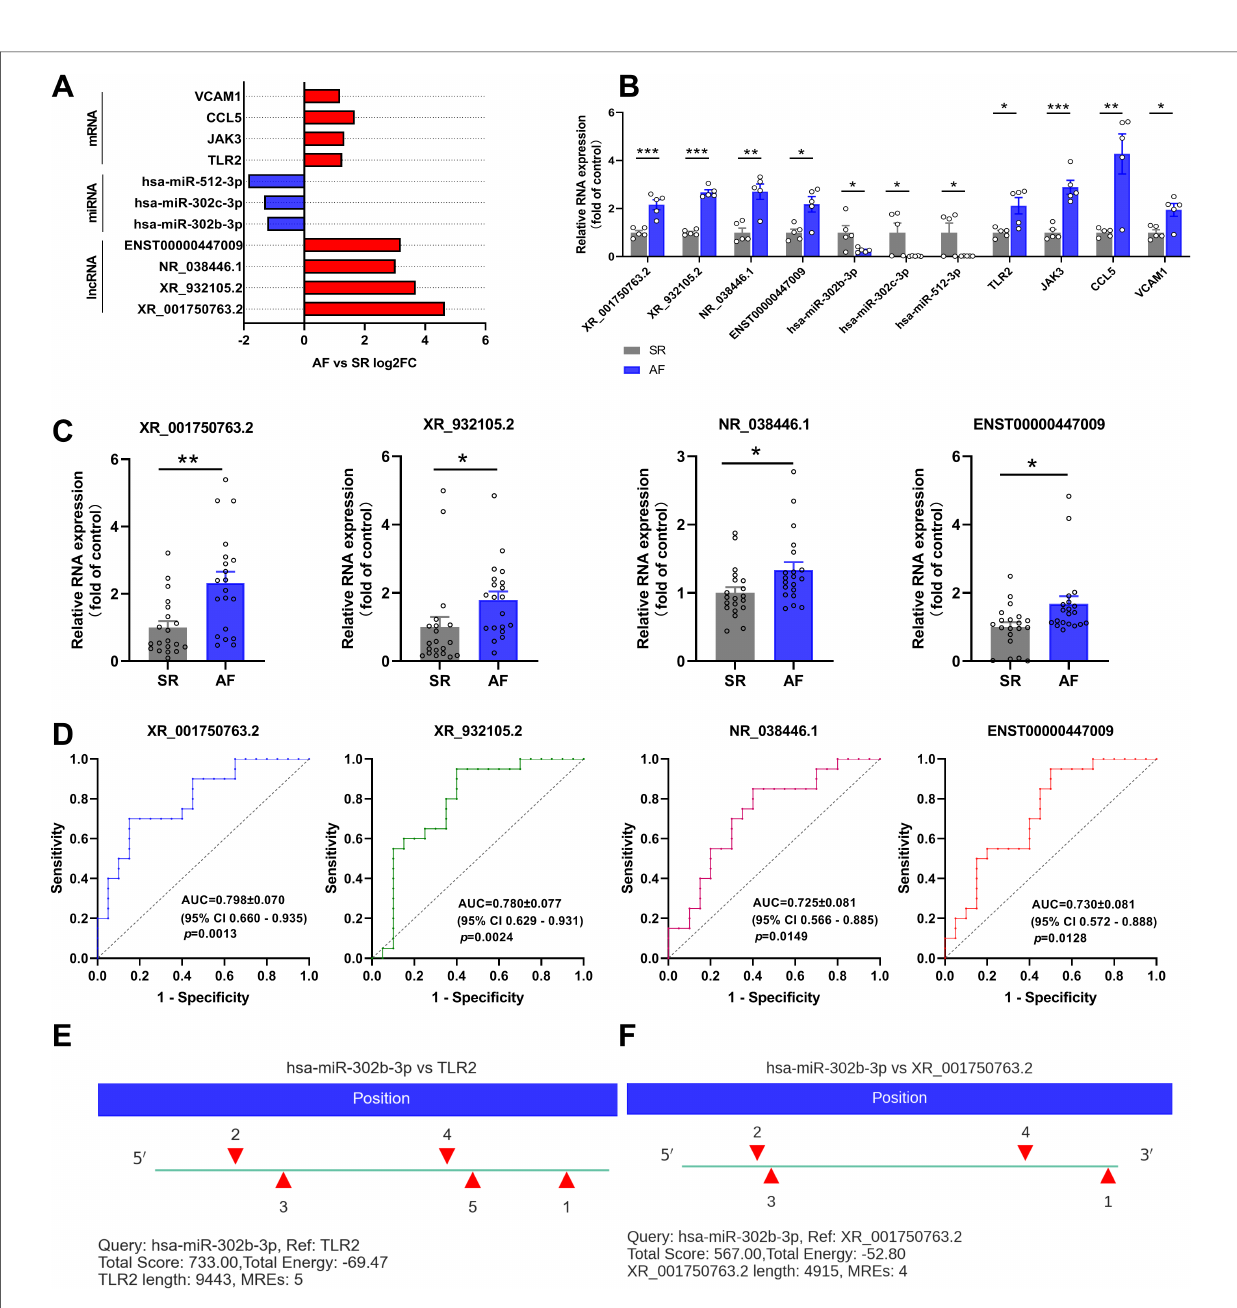
FIGURE 7 Veri fi cation of the differentially expressed (DE) lncRNAs, miRNAs, and mRNAs. ( A ) Fold change for each lncRNA, miRNA, and mRNA as indicated by RNA sequencing. ( B ) qRT-PCR was used to verify the selected DE lncRNAs, miRNAs and mRNAs in left atrial appendage (LAA) tissues. ( C ) qRT-PCR was used to verify the selected DE lncRNAs in the peripheral blood of patients. ( D ) Receiver operating characteristic curve analysis of each lncRNA to distinguish patients with AF from the SR. AUC, area under the curve; CI, con fi dence interval. ( E,F ) The miR-302b-3p binding sites on XR_001750763.2 and TLR2 were predicted by